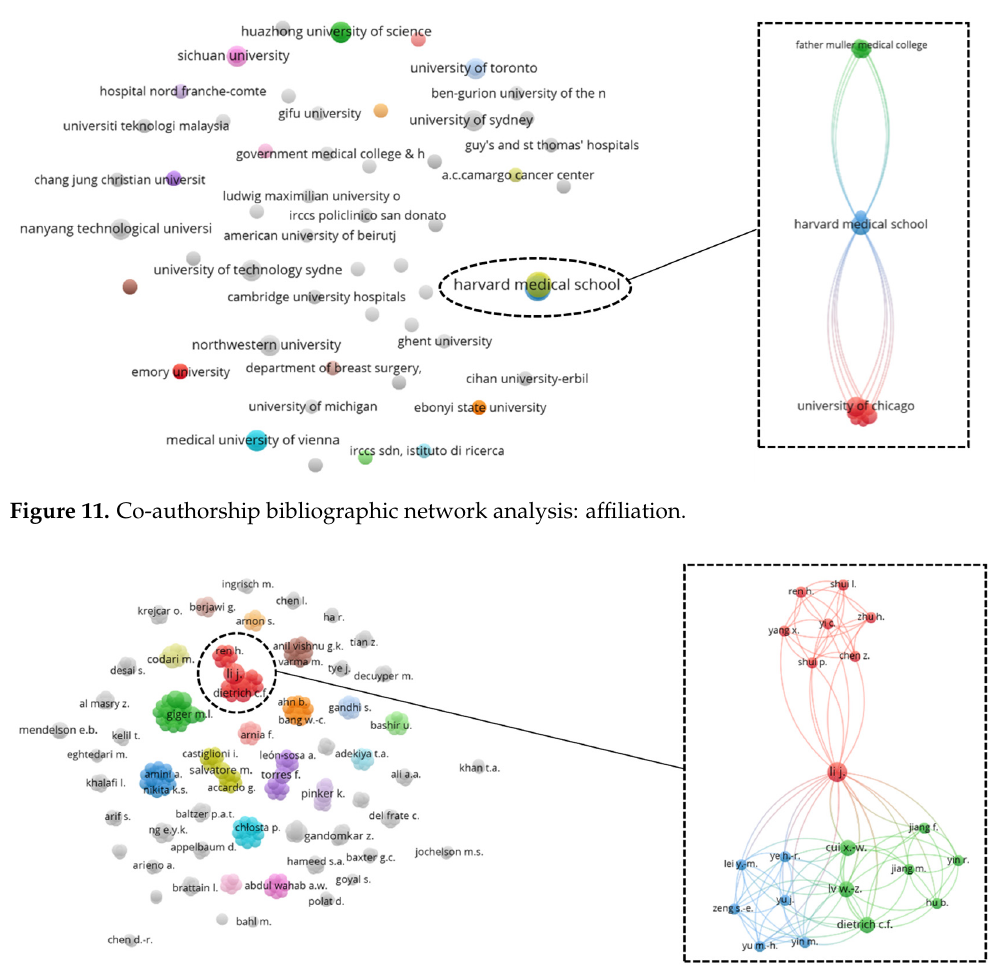
Figure 10. Geographical scientometric analysis of the included review works.